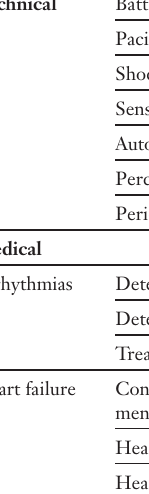
Examples of com- monly detected and transmitted data in remote device